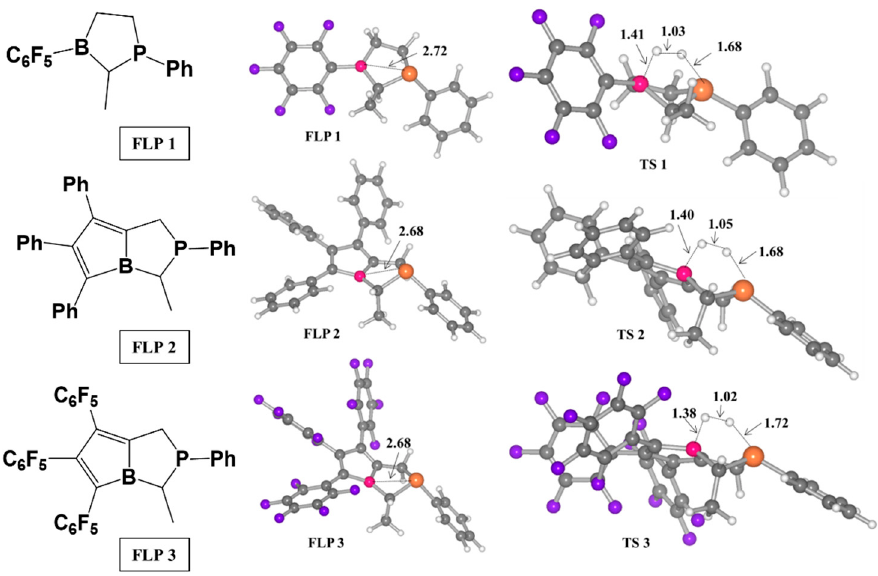
Figure 9. Schematic diagrams and optimized geometries of the FLPs and the related TSs for H 2 activation. Bond distances are provided in Å unit. (Adapted from ref. [96] with permission from Springer Nature. Copyright © 2022, Springer-Verlag GmbH Germany).